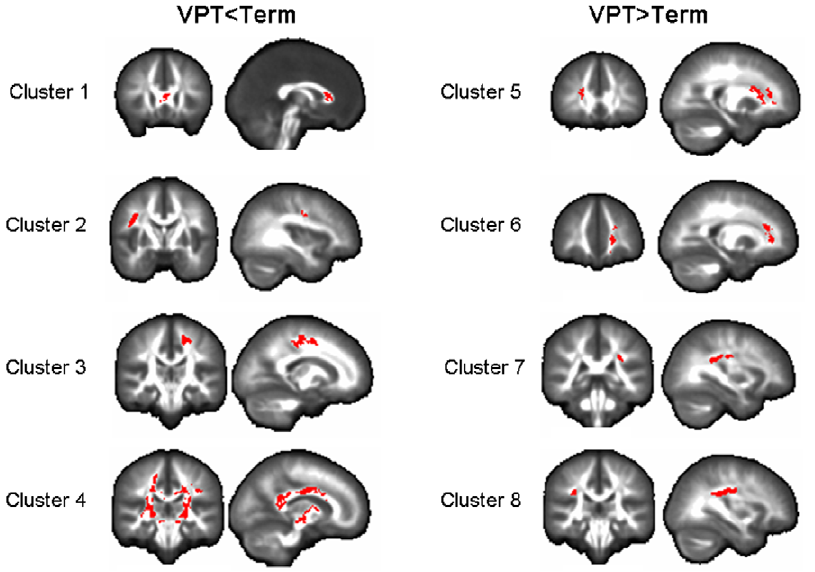
Figure 1. Group differences in FA, displayed on a white matter template. Group differences in fractional anisotropy, displayed on representative white matter template using MRIcro (http://www.cabiatl.com/mricro/). One sagittal and one coronal view is displayed for each cluster showing significant group differences. Cluster numbers refer to Table 1, where MNI coordinates and tract identification are given.